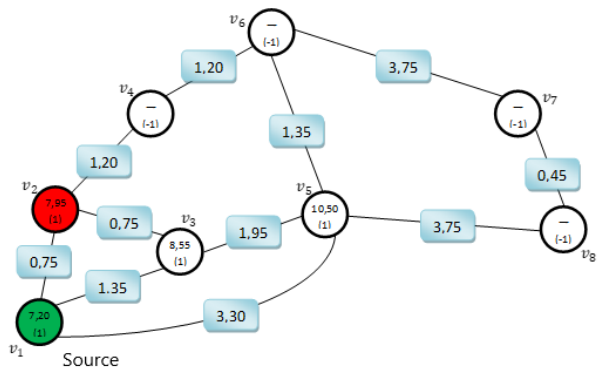
Figure 4. Finding the optimal path from peak 1—step 1.